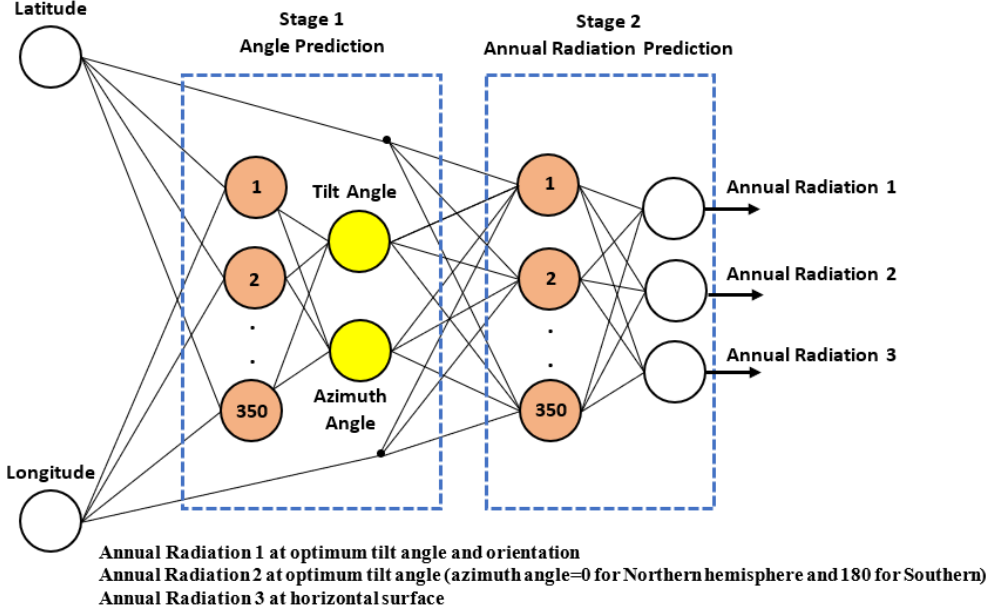
Figure 4. The developed neural network topology.